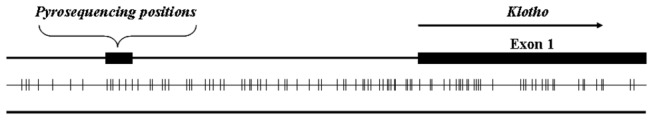
Map of sequencing sites of the Klotho gene.Exon and pyrosequencing positions are shown in top line. CpG dinucleotides are shown in bottomline. Each short vertical bar represents a CpG site. The methylation levels of 6 CpG sites of Klotho are determined.